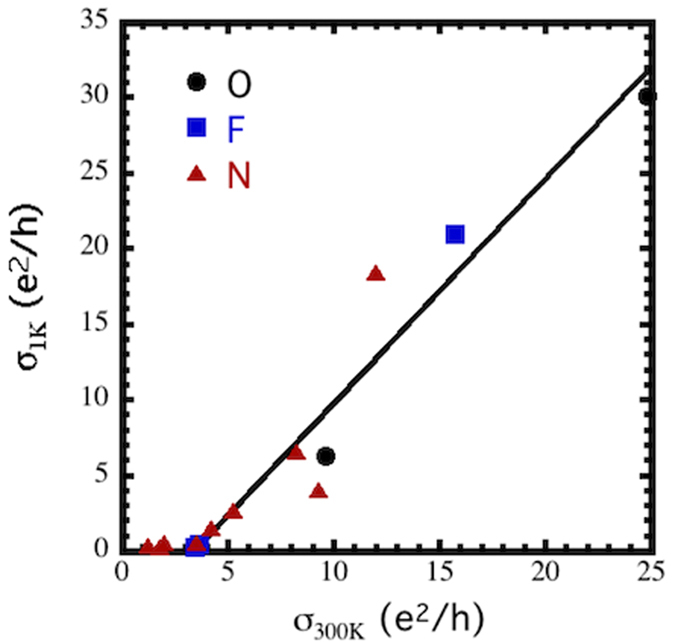
Conductivity at 1 K vs. conductivity at 300 K showing the continuous nature of the conductivity as the sample approaches the MIT similar to the linear “mobility edge” observed in many three dimensional systems.The line is a linear fit to the data for σ1K > 0. F, O, and N refer to samples subject to plasmas containing SF6, O2, and N2, respectively.